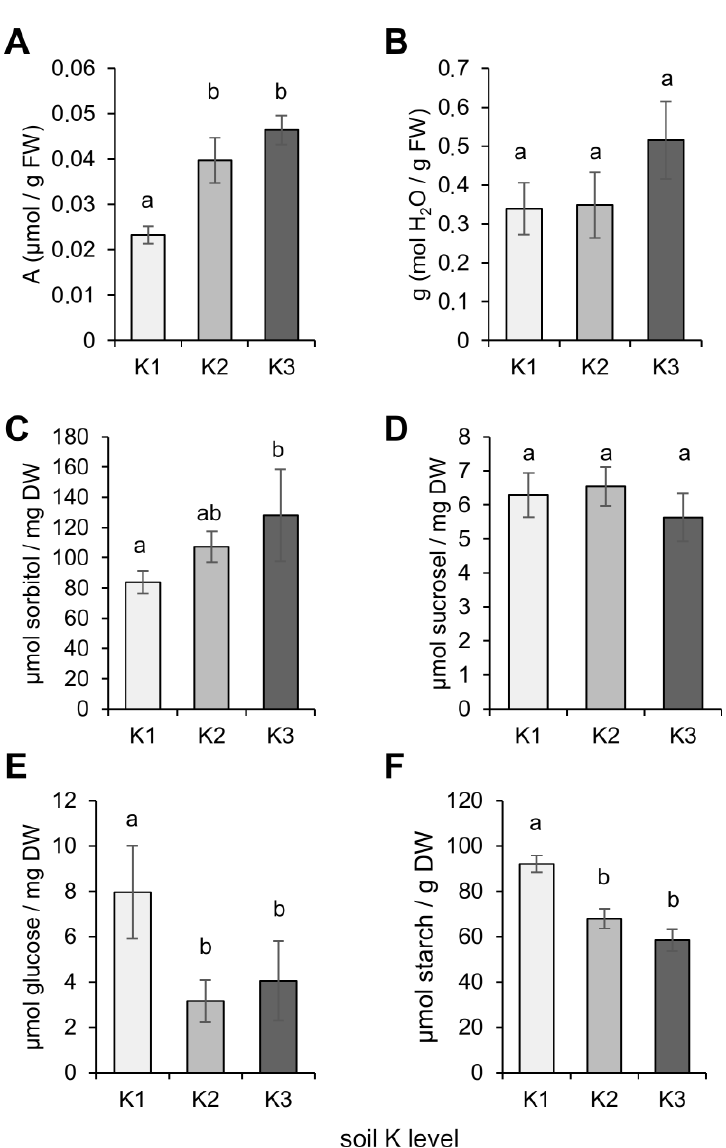
Figure 4. Effect of different soil K levels on the gas exchange parameters and the assimilation rate of P. major plants. ( A ) CO 2 assimilation rate recorded in the light ( A ), ( B ) stomatal conductance ( g ) in the light, ( C – F ) assimilate contents of shoots—( C ) sorbitol, ( D ) sucrose, ( E ) glucose, and ( F ) starch. Bars are means of n = 4 ( A – D ) or n = 5 ( D – F ) biological replicates ± SE. Different letters above bars indicate significant differences according to one-way ANOVA, with post-hoc Tukey HSD test ( p < 0.05).